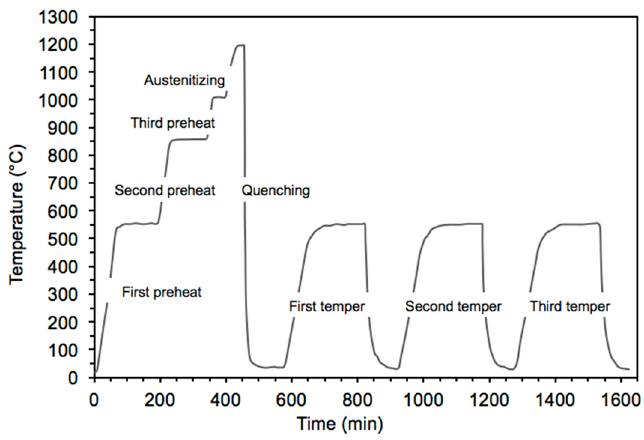
Figure 1. Conventional heat treatment (CHT_5) applied to the taps.